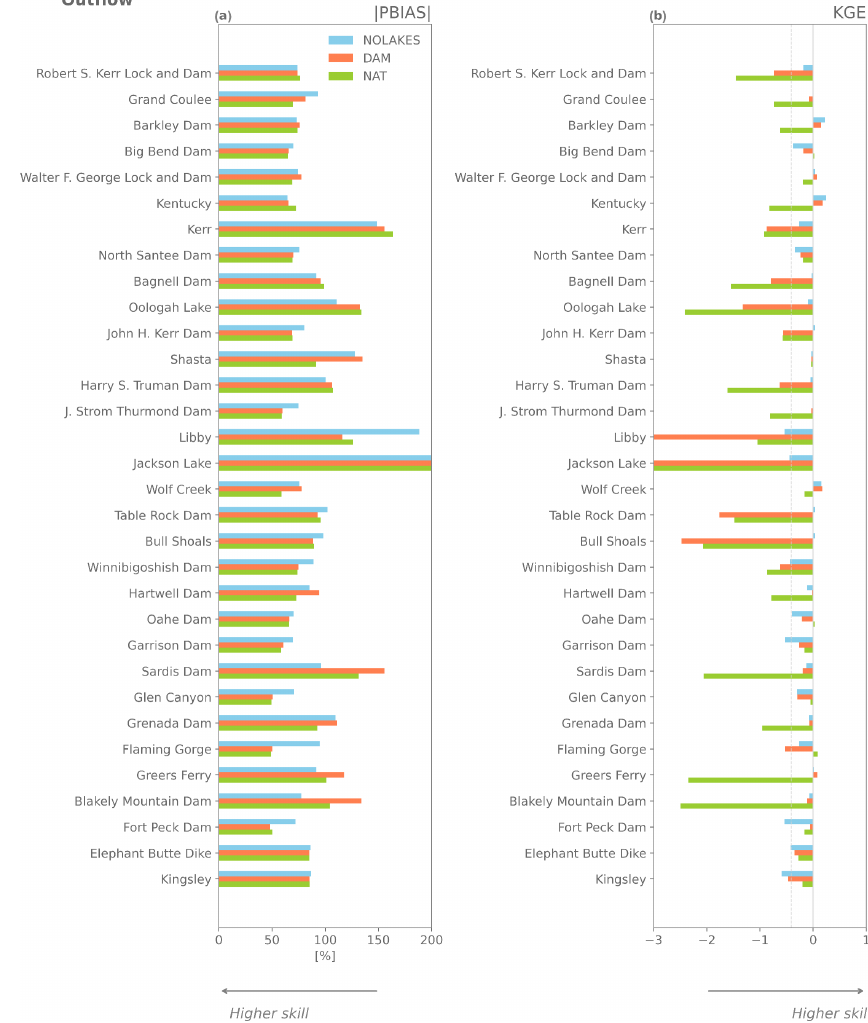
Figure A5. Performance of the global-scale mizuRoute simulations for outflow compared to reservoir observations from the ResOpsUs dataset (Steyaert et al., 2022) using absolute percent bias ( | PBIAS | , a ) and Kling–Gupta efficiency (KGE, b ).